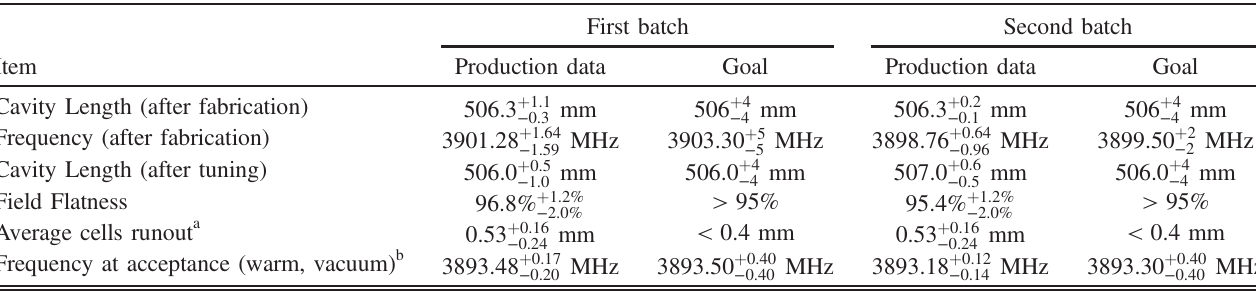
TABLE V. EXFEL series production results. The uncertainties are expressed as the maximum spread of the measured data. First batch Second batch Production